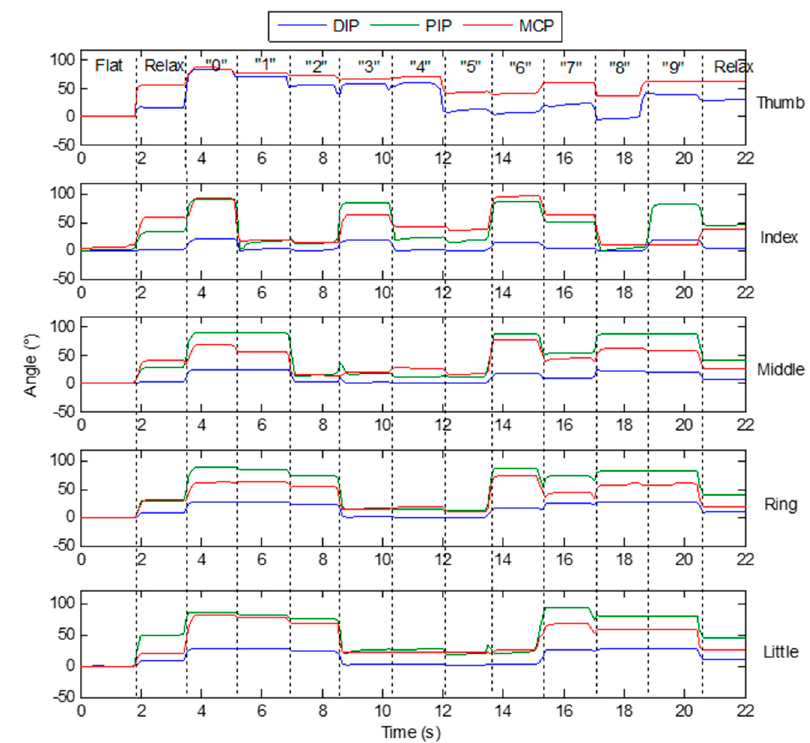
Figure 19. Digital gestures for 0 to 9.